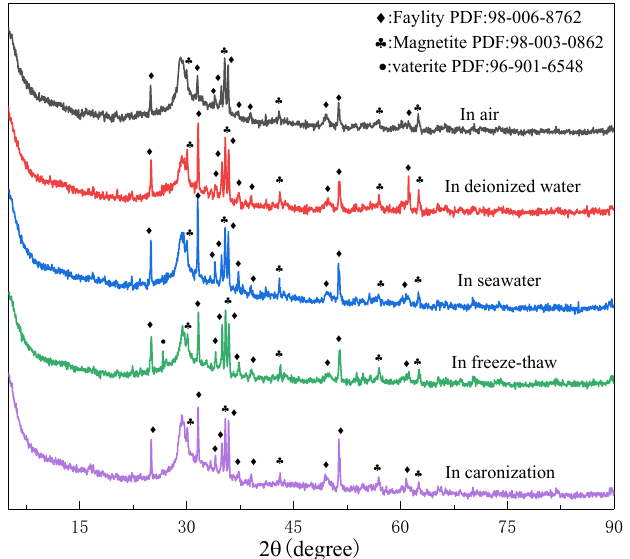
Figure 3. XRD patterns of geopolymers prepared with 60% BFS that underwent different exposures for 28 days.